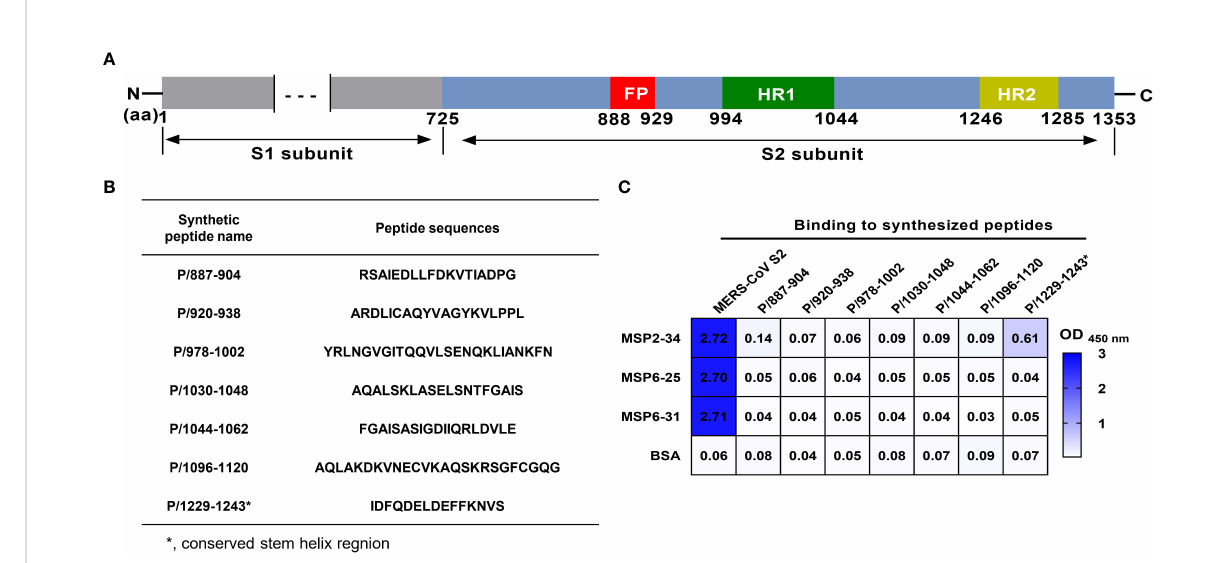
FIGURE 5 Binding of mAbs to different synthetic MERS-CoV S2 peptides. (A) Diagram of MERS-CoV S protein. Amino acid (aa) positions are referred to the sequence of strain HCoV-EMC (GenBank: AFS88936.1). (B) Amino acid sequence of peptides. (C) Binding of mAbs MSP2-34, MSP6-25,